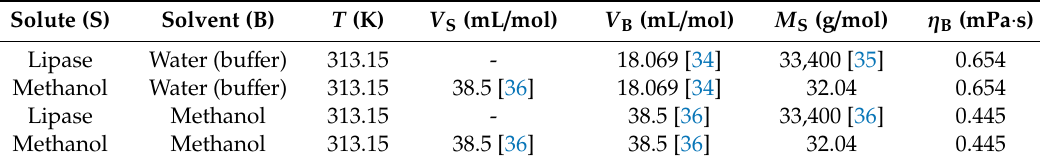
Table 1. Properties of methanol, water (bu ff er) and